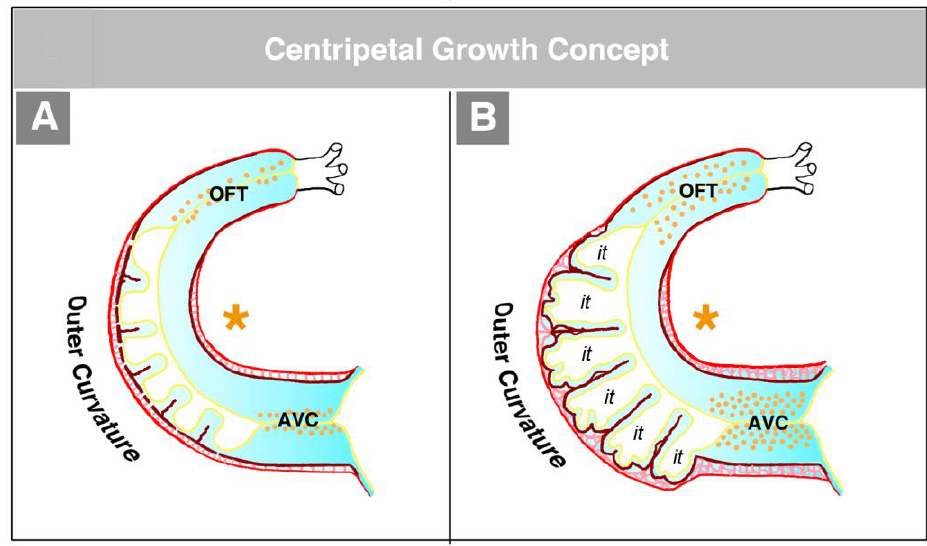
Figure 15. These schematic drawings illustrate the centripetal growth concept of ventricular trabeculation. ( A ) Initial step of trabeculation. ( B ) Advanced step of trabeculation. According to this concept, myocardial trabeculae are formed mainly from cardiomyocytes of the inner (basal) layer of the ventricular myocardium (marked by dark red color). Recent data suggest that non-removed remnants of CJ along the outer curvature of the ventricular bend serve as pathways for inward growth of the trabeculae toward the center of the embryonic ventricle. Inward growth of myocardial trabeculae separates endocardium-lined intertrabecular spaces ( it ) from the free ventricular lumen. Outward growth of endocardial sprouting into the myocardial wall does not significantly contribute to the formation of intertrabecular spaces. Note that inward growth of trabeculae is expected to narrow the free lumen of the embryonic ventricles during the initial step of trabeculation. Note also that the embryonic ventricles expand (ballooning) concomitant with the growth of the trabeculae. Same color code and abbreviations as used in Figure 13.